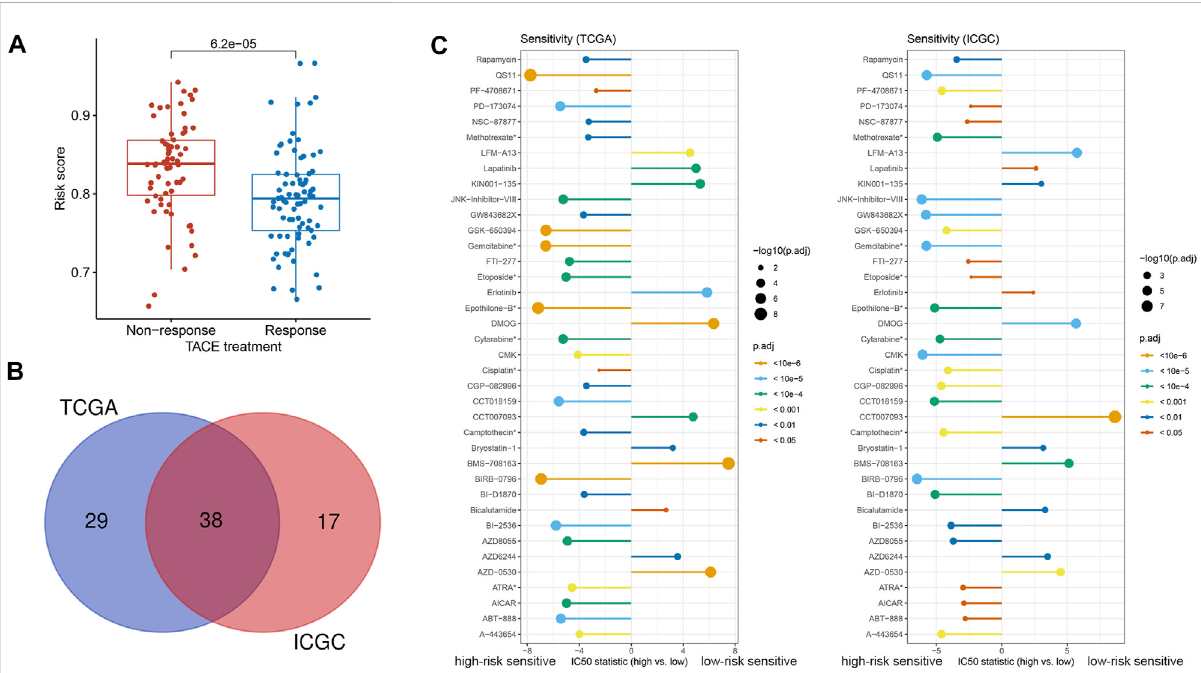
FIGURE 6 Treatment ef fi cacy based on the 2-TF signature (A) The correlation between response to TACE treatment and risk score in GSE104580 (B) The common agents estimated to have different IC 50 according to the risk score both in the TCGA and ICGC cohorts (C) The discrepancy of estimated IC 50 in the high- and low-risk groups in the TCGA and ICGC cohorts. *Chemotherapeutic agents; TF, transcription factor; IC 50 : half-maximal inhibitory concentration; TACE: transarterial chemoembolization; TCGA, The Cancer Genome Atlas; ICGC, International Cancer Genome